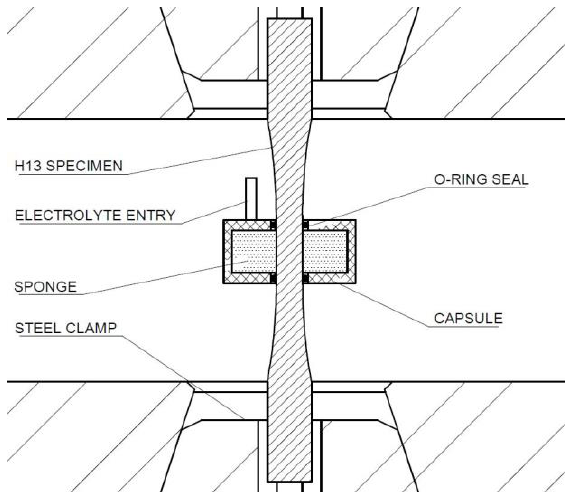
Figure 2. Schematics of the corrosion fatigue testing setup for surface soaking.